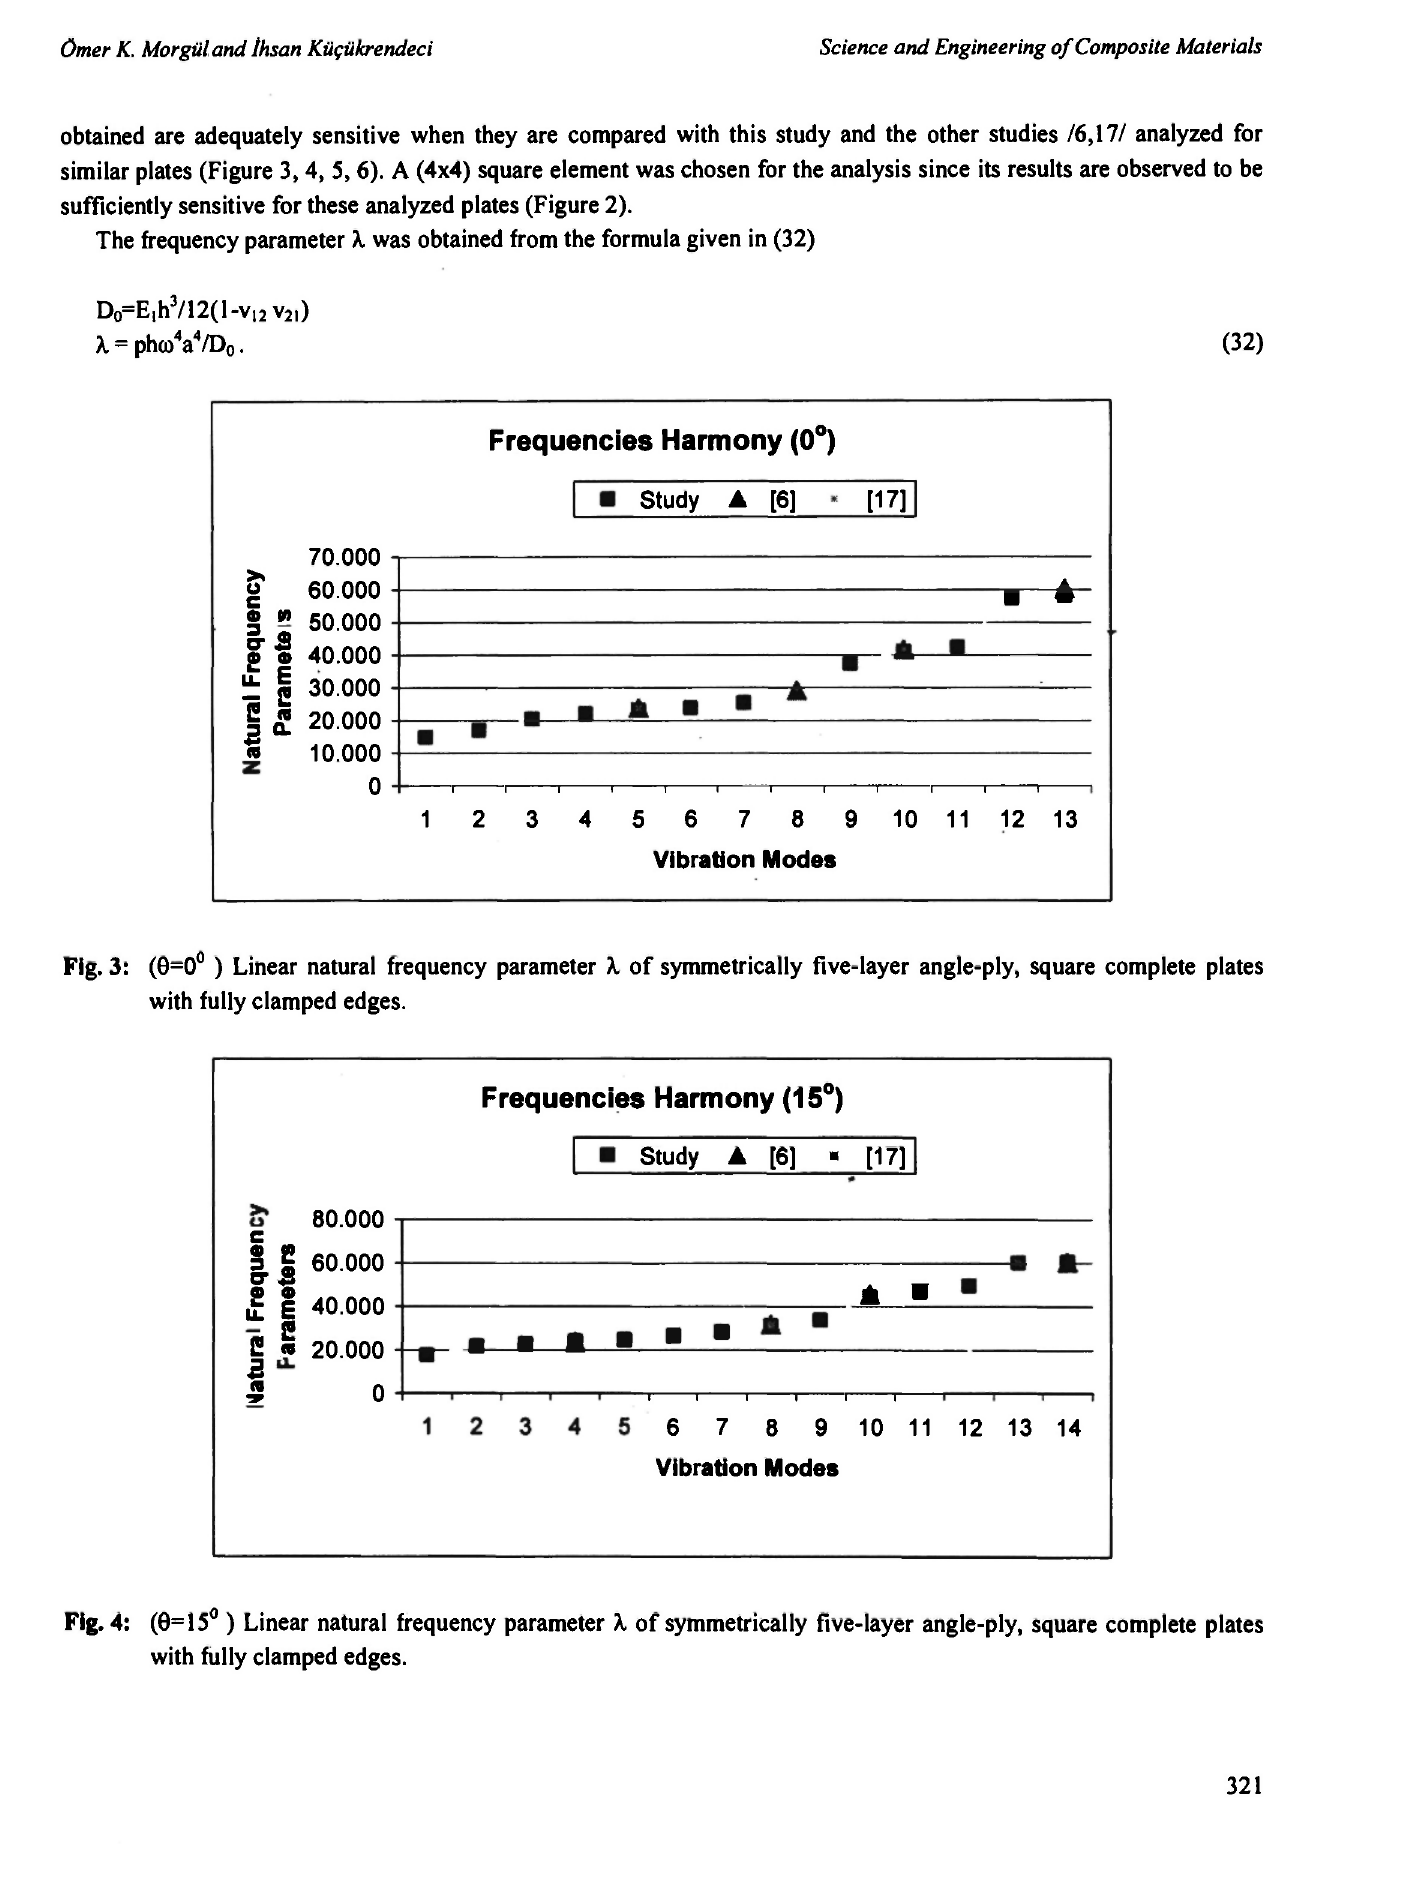
Fig. 4: (0=15° ) Linear natural frequency parameter λ of symmetrically five-layer angle-ply, square complete plates with fully clamped